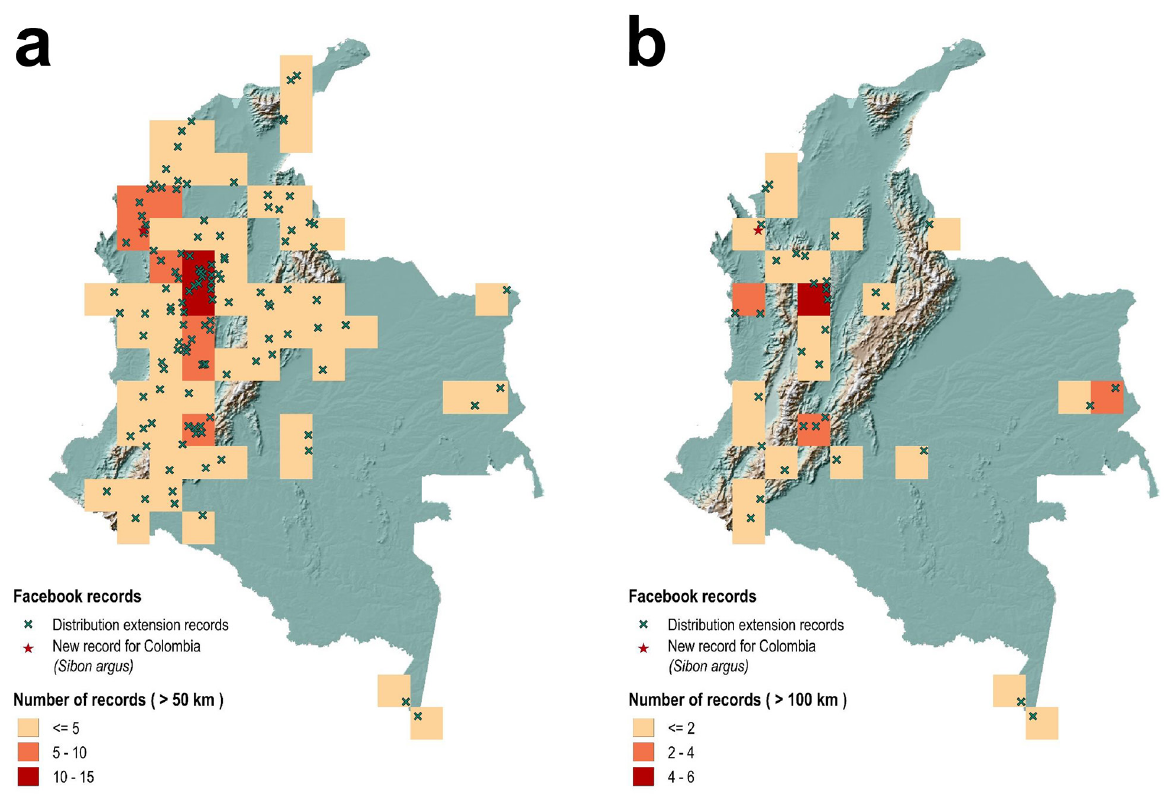
Figure 4. Distribution extensions derived from Facebook posts of Colombian snake species reported in the Global Biodiversity Information Facility (GBIF). (a) Records that fall outside the 50-km buffer around available GBIF records. Distribution extensions were documented for 176 species, and most Facebook-based distribution extensions were in the trans-Andean region of Colombia, but the most conspicuous extensions to the distributions of species were in the cis-Andean region. (b) Records that fall outside the 100-km buffer around available GBIF records. Distribution extensions were documented for 40 species, and most Facebook-based distribution extensions were in the trans-Andean region, but the most conspicuous extensions to the distributions of species were in the cis-Andean